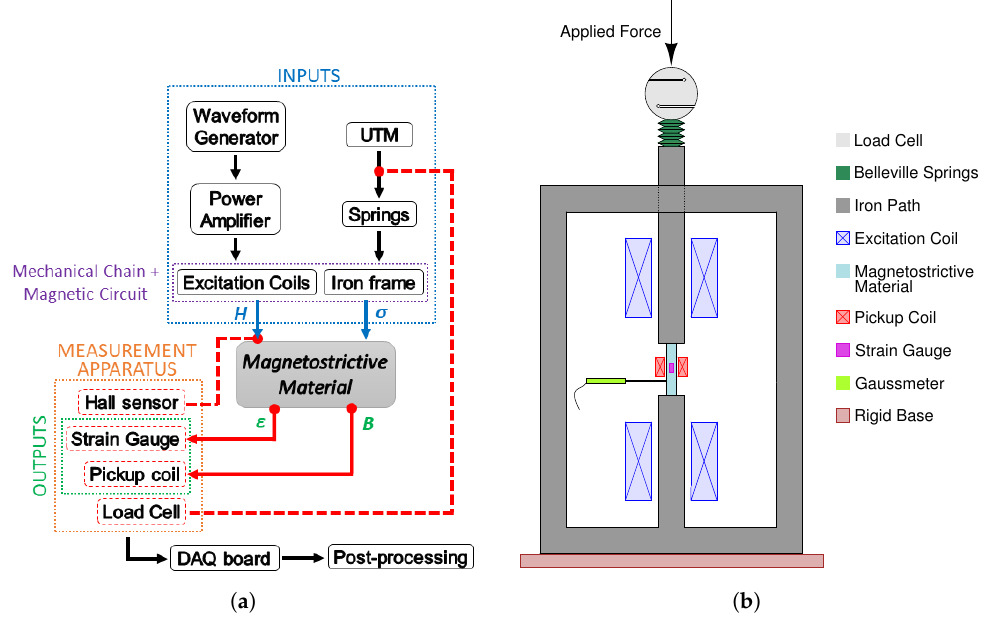
Figure 2. Experimental setup adopted to characterize magnetostrictive materials: ( a ) blocks diagram of the devices and quantities involved in the measurements; ( b ) a 2D-sketch of the whole apparatus. The output M is obtained from B by means of Equation